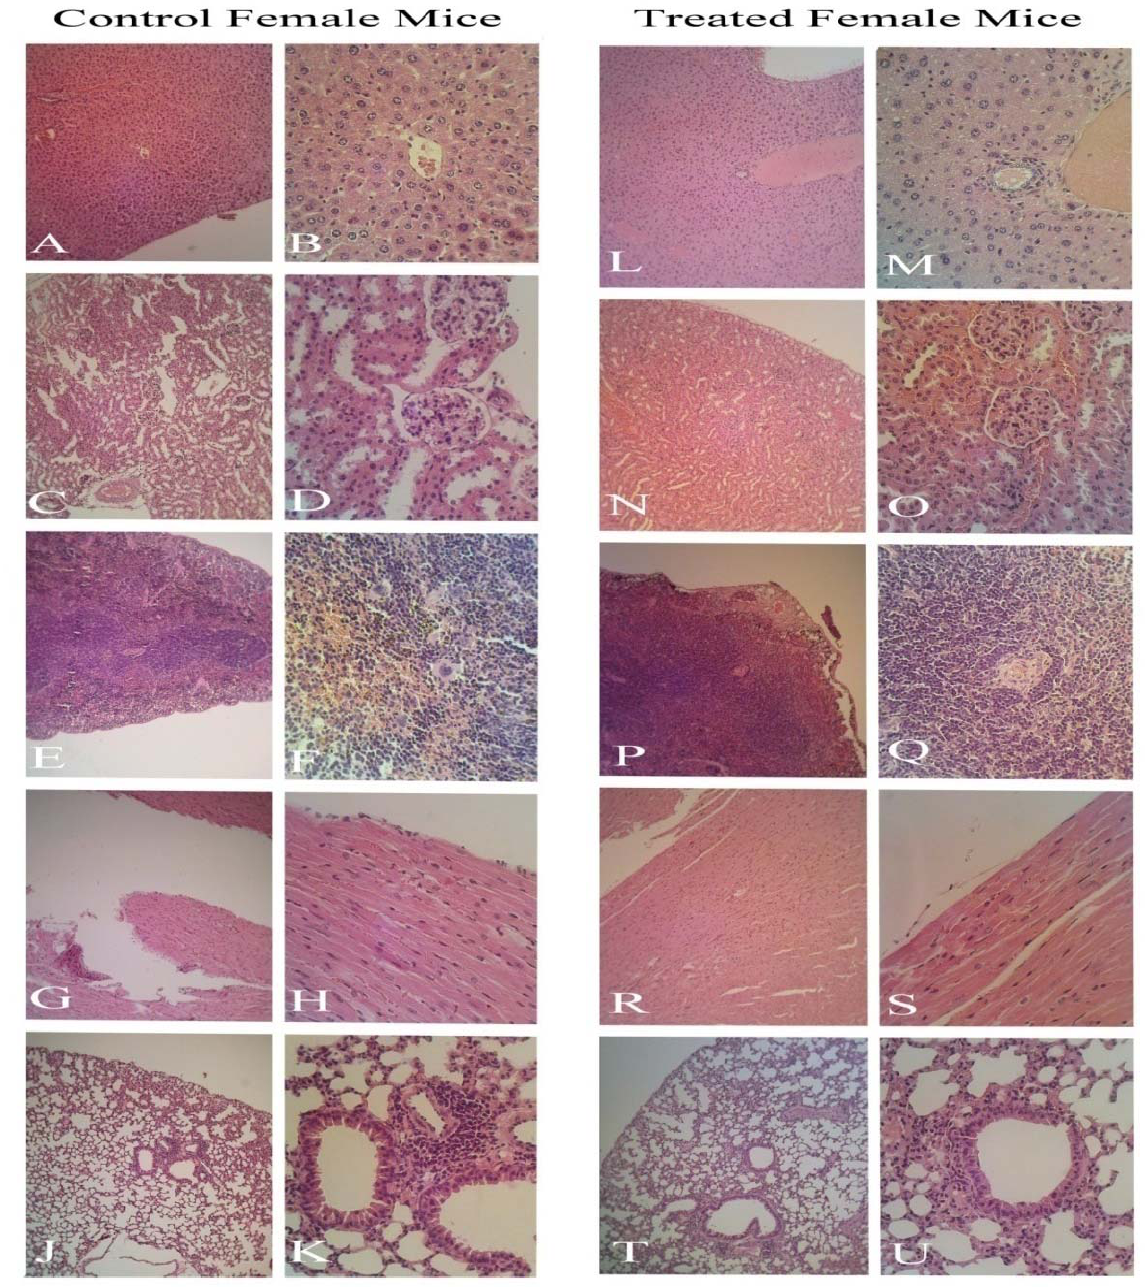
Figure 4. Histological (female mice) examination of A, B, L, M: Liver; C, D, N, O: Kidney; E, F, P, Q: Spleen; G, H, R, S: Heart; J, K, T, U: Lung. Magnification for left side slides of each category is 100×; right side, 400×. The focus of picture at the center in 400× powers is on central vein in liver, glomerule in kidney, white pulp in spleen, terminal bronchiole in